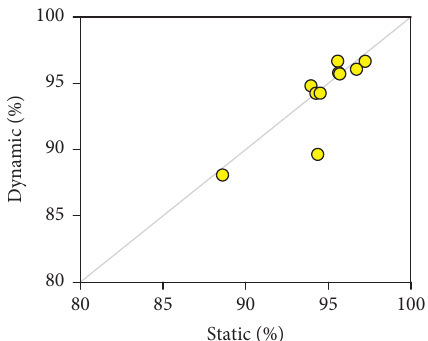
Figure 5: Quality level for the input video records of each participant, under static or dynamic VR input